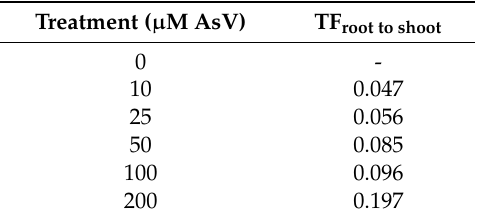
Figure 4. Arsenic content in roots and shoots of 26-d-old rice seedlings grown in hydroponic solutions supplemented the last 12 days with di ff erent AsV concentrations. Data are means ± SEM of at least three independent experiments. One-way Anova was used for comparisons between means using the program Statgraphics Centurion. Di ff erent letters over the columns for each organ (either shoot or root) indicate that di ff erences with respect to control (0 µ M AsV) values were statistically significant at p < 0.05. DW, dry weight. Table 1. Translocation factor (TF root to shoot ) in 26-d-old rice seedlings grown in hydroponic solutions supplemented with different AsV concentrations during the last 12 days. For the estimation of TF, the following formula was applied, TF root to shoot = [As shoot]/[As root].